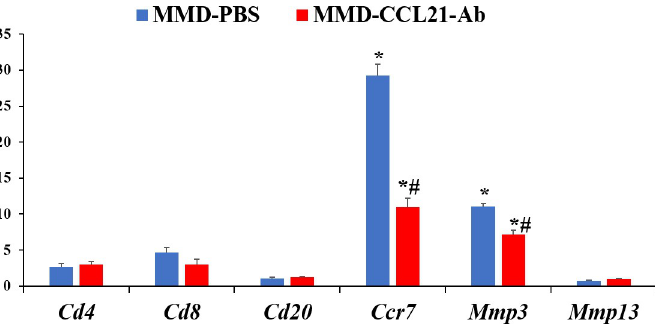
Fig 9. Effect of blocking the function of CCL21 in rat knees, on Mmp3 and Mmp13 and four markers of inflammatory cell subsets, at day five post-knee surgery. Right knees (Rk) were MMD-operated and left knees (Lk) were un-operated. Data are expressed as fold change of the expression of each gene in the Rk treated with either CCL21-Ab or PBS vs Lk. PBS and are represented as mean ± SE. n = 4, � P � 0.05 vs Lk. PBS and #P � 0.05 Rk- CCL21-Ab vs Rk-PBS.